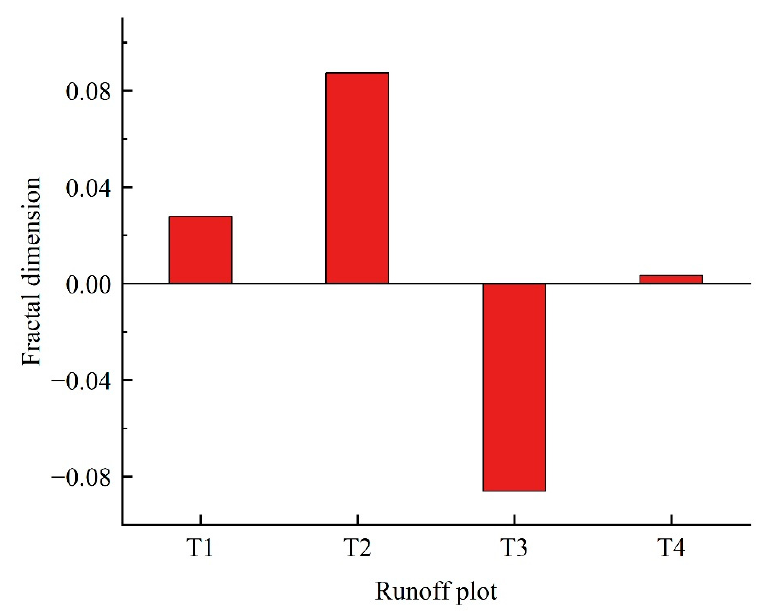
Figure 3. Changes in soil fractal dimensions in different hedgerow plots.